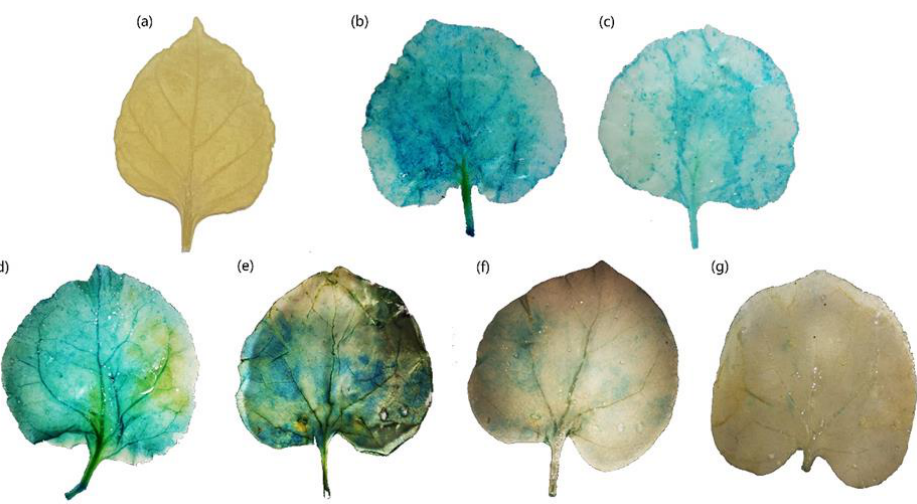
Figure 3. Activity analysis of different deletion constructs of TkSRPP promoter in tobacco plants. ( a ): Blank control; ( b ): CAMV 35S promoter regulates GUS expression; ( c – g ): the GUS activity was regulated by PR0, PR1, PR2, PR3 and PR4, respectively. The GUS histochemical staining of five deletion constructs was performed using transient transformation methods.